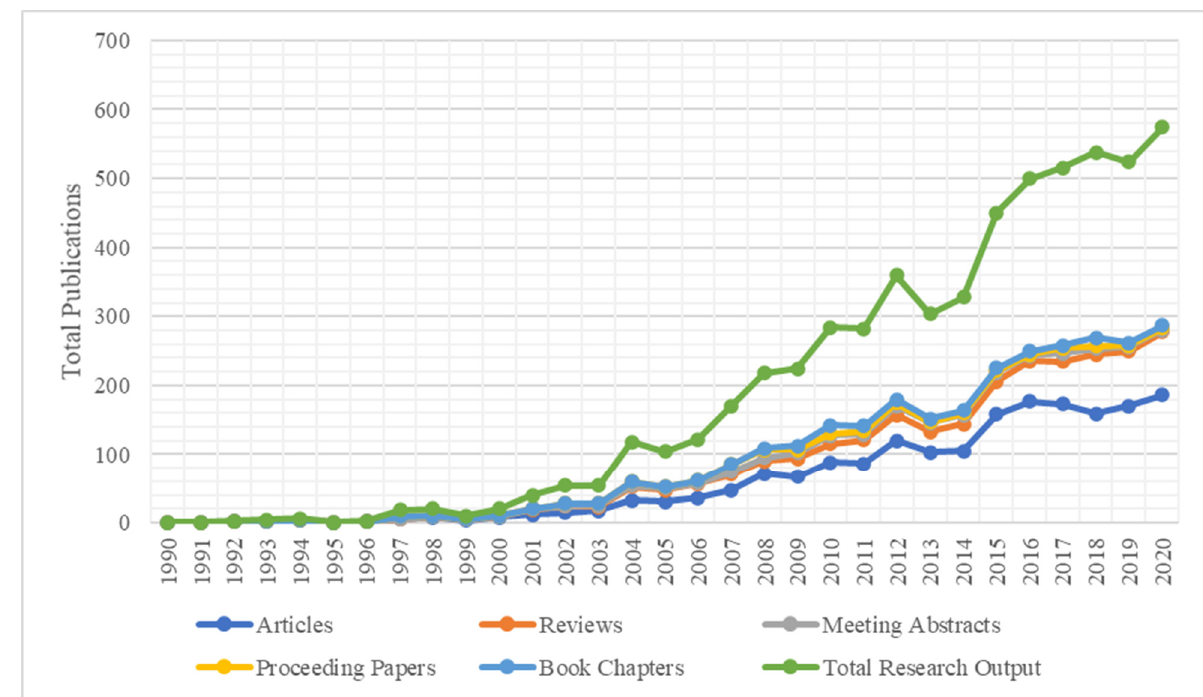
Figure 2. Scientific output in stem cell therapy for diabetes mellitus from 1990–2019. Bioengineering 2021 , 8 , x FOR PEER REVIEW